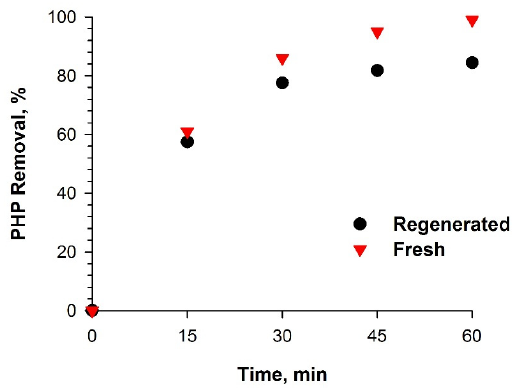
Fig. 12. Reusability of the nanocatalyst. Reaction conditions: pH = 7, 0.1 A, [PHP] =10 ppm, and [catalyst] = 0.2 g L -1 .